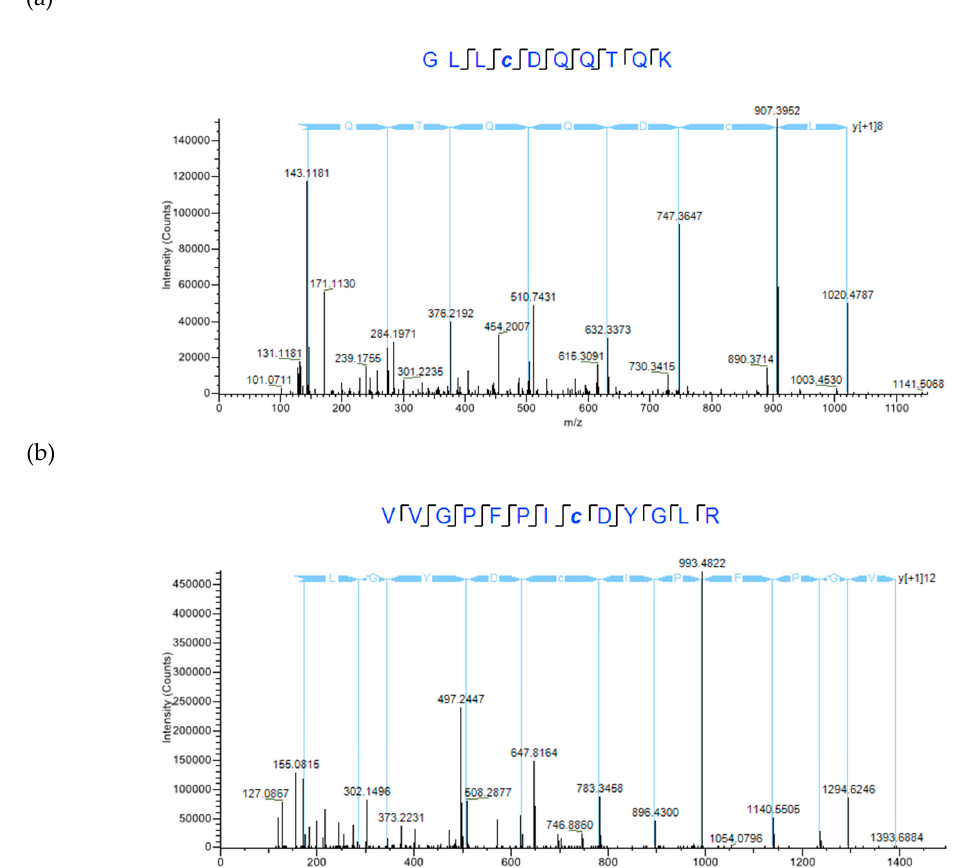
( b ) Figure 2. Isolation of recombinant black widow CRP1 and CRP4 from E. coli crude extract. SDS-PAGE analysis of purified CRP1 and CRP4 after affinity chromatography using a Ni-NTA agarose resin. Ubiquitin-like protease (ULP1) was used to remove the 10×His-SUMO tags from purified 10×His- SUMO-CRP1 and 10×His-SUMO-CRP4. Proteins were visualized using silver staining. FT = flow through; W1 and W4 = wash 1 and 4; E = elution 1 and 2; L = protein ladder in kDa; -SUMO = removal of tag. Asterisks represent cysteine-rich proteins (CRPs) lacking tags. ( a) CRP1; ( b) CRP4. Because the 10×His-SUMO appendage could potentially influence secondary structural characteristics of CRP1 and CRP4, we employed a strategy to remove the 10×His-SUMO tag from the CRPs. Purified 10×His-SUMO-CRP1 and 10×His-SUMO-CRP4 were treated with recombinant ubiquitin-like-specific protease 1 (ULP1) to remove the 10×His-SUMO segment. After incubation of 10×His-SUMO-CRP1 or CRP4 with ULP1, His-tagged ULP1, 10×His-SUMO, and the CRP components were reapplied to a nickel-NTA agarose column, which allowed for capturing of the His- tagged ULP1 and 10×His-SUMO region. Analysis of the ULP1-cleaved flow through CRP1 and CRP4 samples by SDS-PAGE analysis, followed by silver staining, detected bands migrating at the expected mass range for CRP1 and CRP4 (Figure 2a,b, lanes 8 [-SUMO], respectively). An additional, slower migrating band was observed for CRP1; this species likely represents a partially unfolded form of CRP1 (Figure 2a, lane 8). To confirm these bands represented CRP1 and CRP4, we performed in-solution tryptic